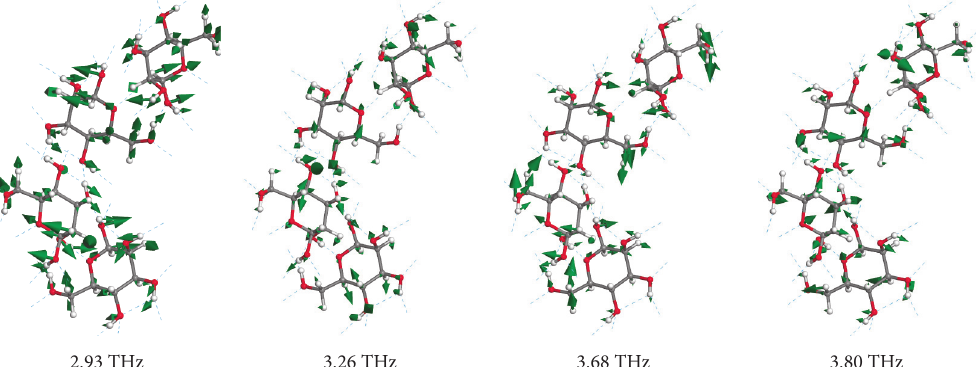
Figure 5: The displacement vector representations of the PBE calculated vibrational modes of mannose at 2.93THz, 3.26 THz, 3.68THz, and 3.80THz.